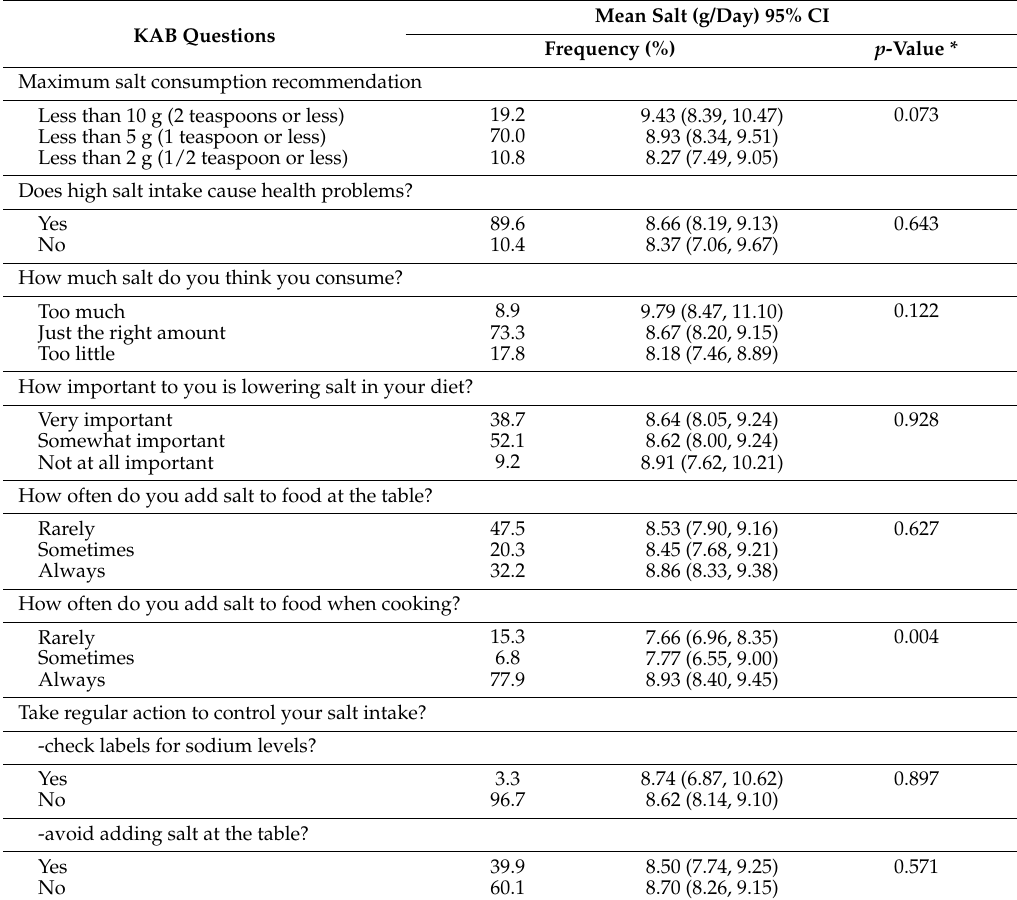
Table 2. Association between knowledge, attitudes and behaviours (KAB) and salt excretion (g/day)